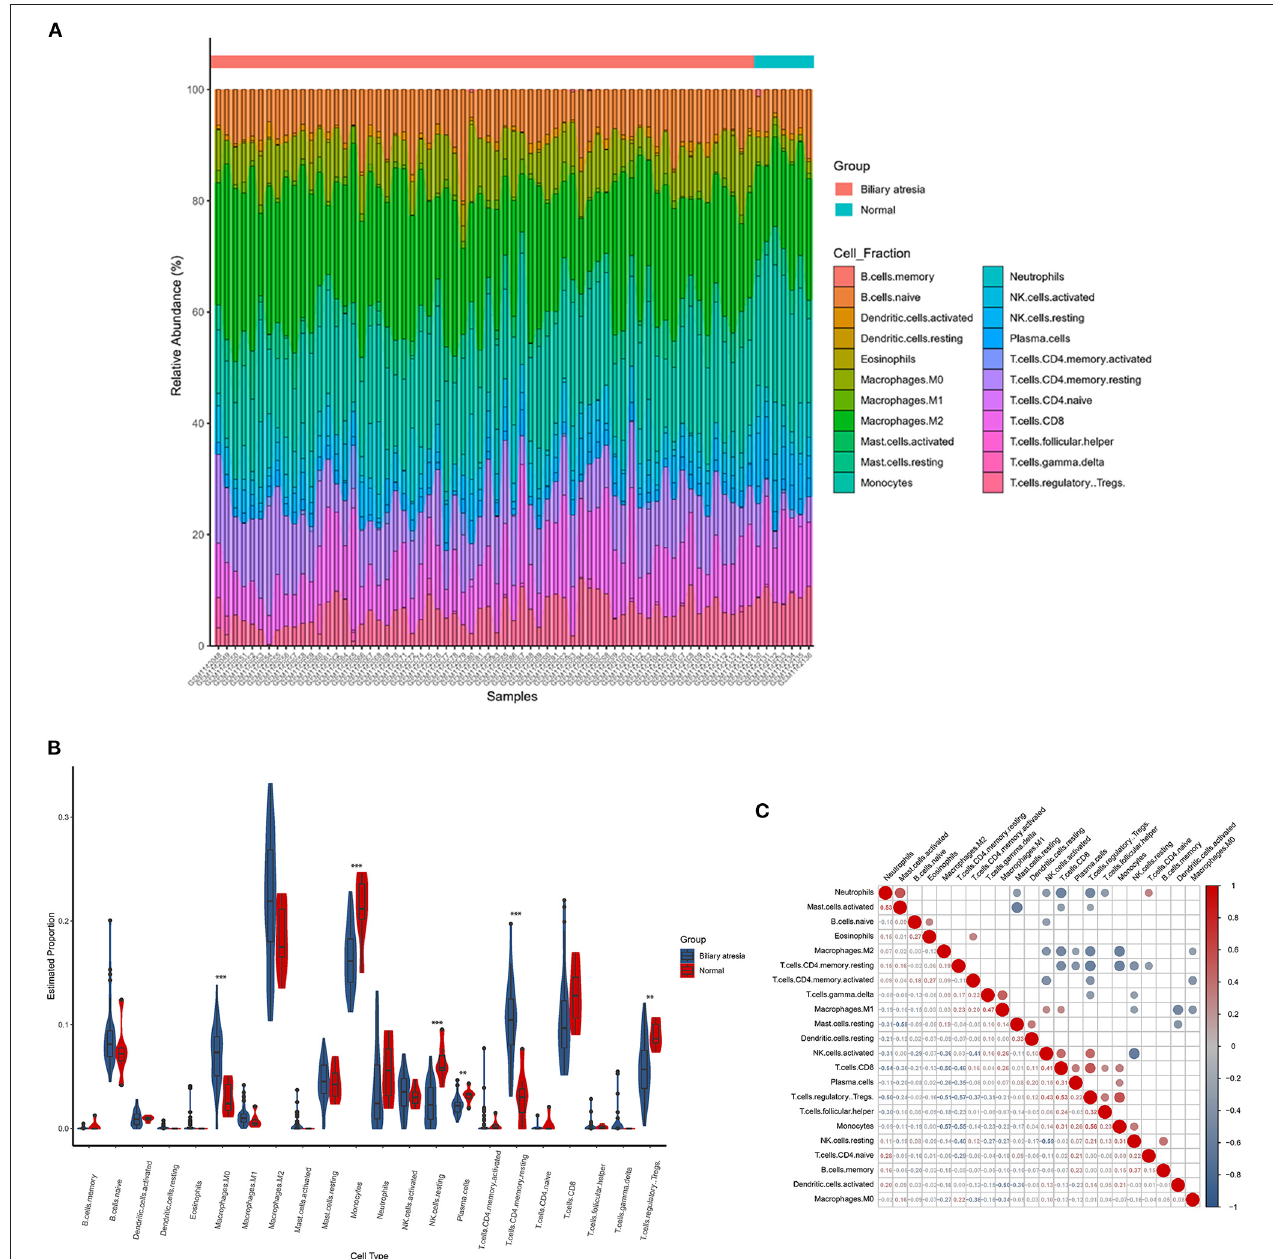
FIGURE 4 | The landscape of immune infiltration between biliary atresia (BA) and normal controls. (A) The box plot diagram indicated the relative percentage of different types of immune cells. (B) The violin plot demonstrated the difference of immune infiltration between BA (blue) and normal (red) controls. (C) The correlation matrix of immune cell proportion in